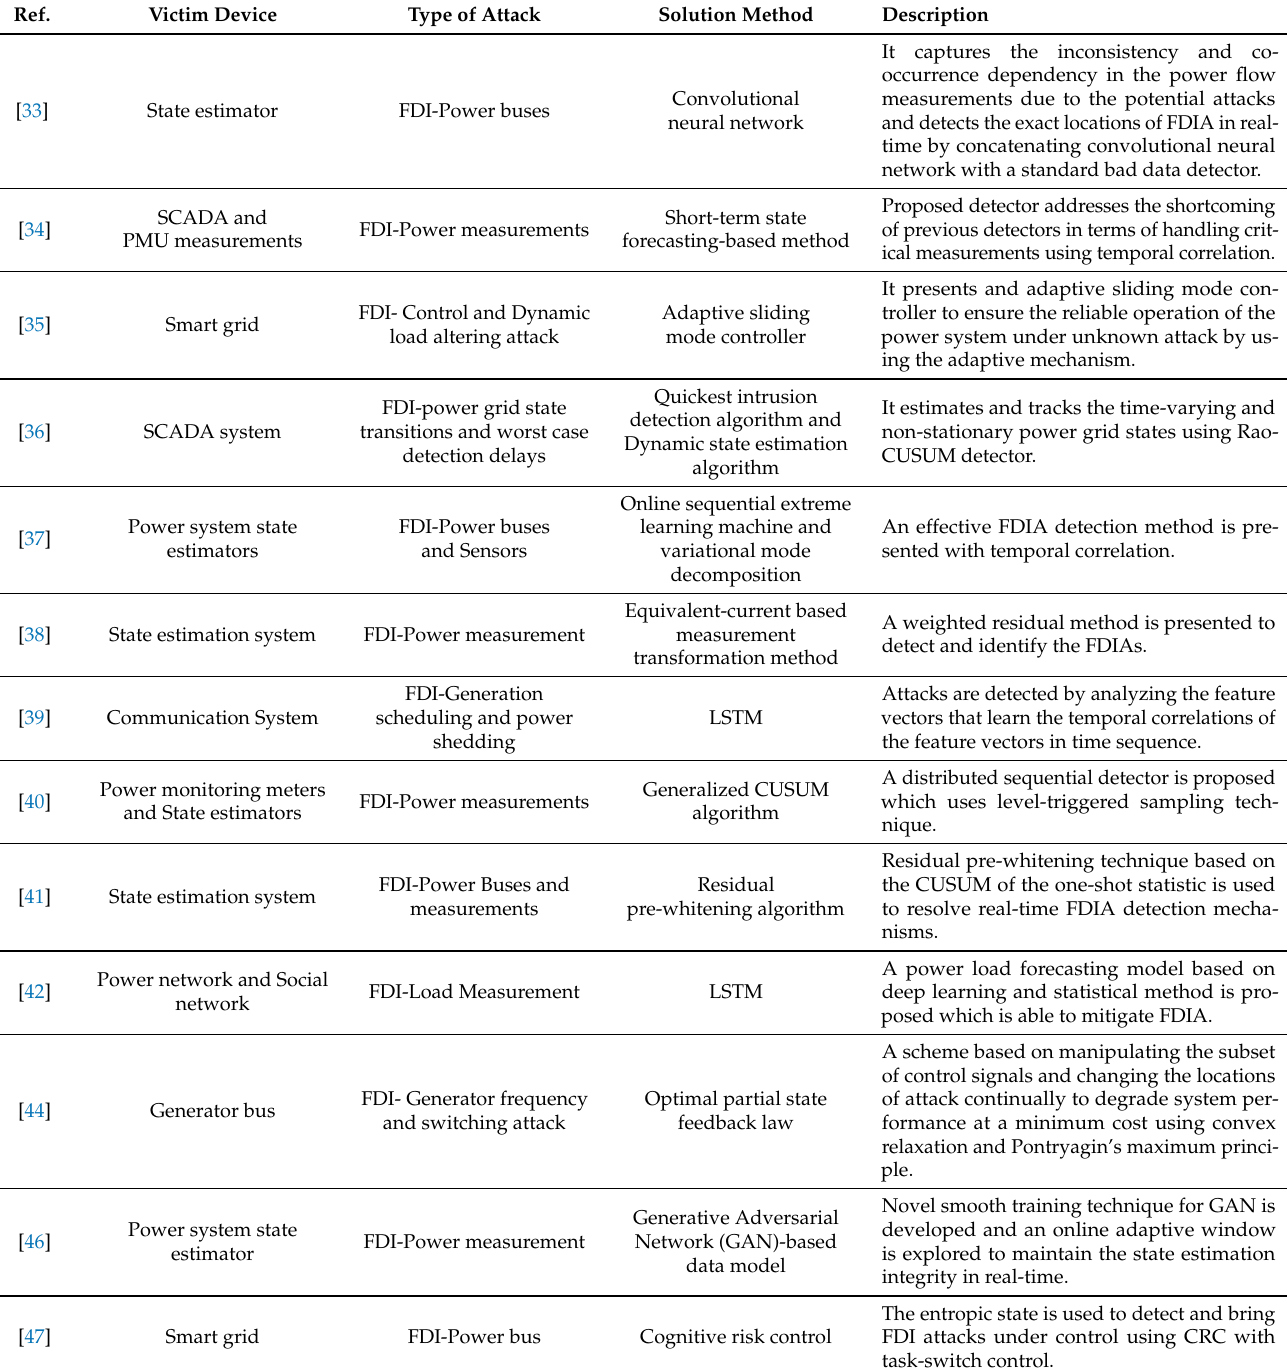
Table 2. Review of false data injection attack detection in smart grid